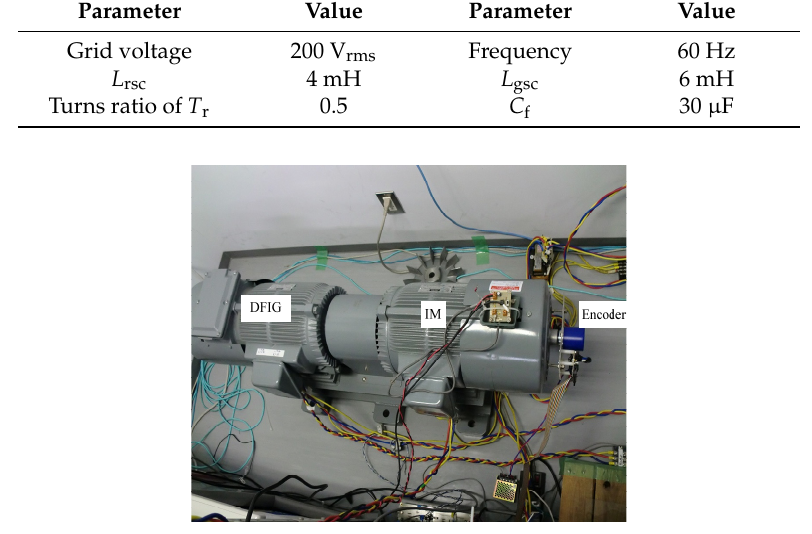
Figure 9. A photo of the experimental rig.